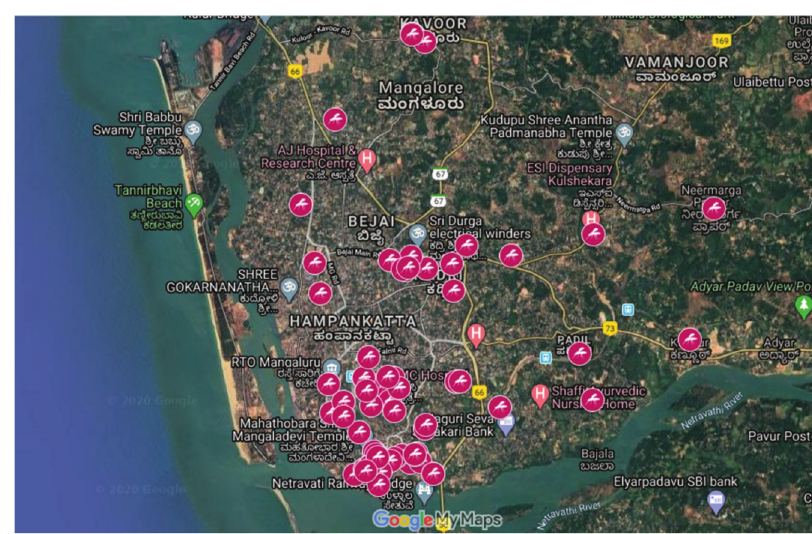
Figure 2: Geospatial mapping of positive dengue cases by RT-PCR in this